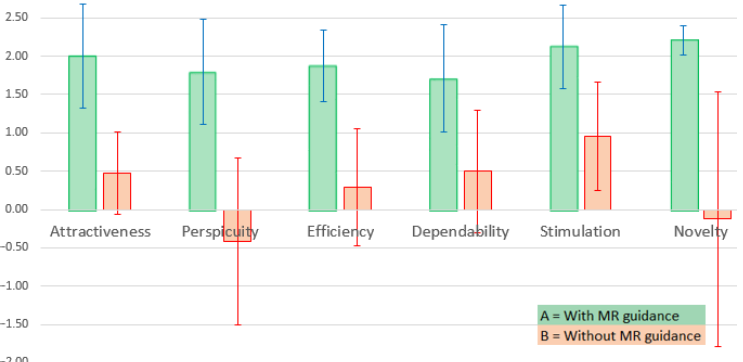
Figure 6. Product assessment result, represented by the comparison of scale means: the chart shows the scale means and corresponding 5% confidence intervals.